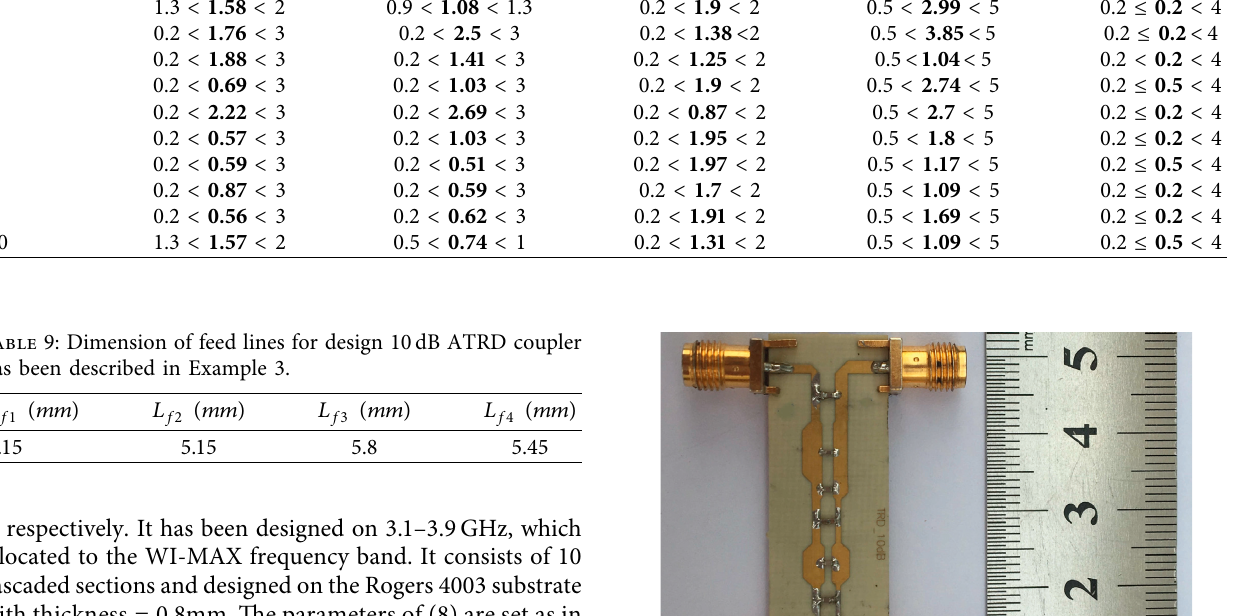
Table 8: Dimension and capacitor value for design 10dB ATRD coupler has been described in Example 3. Section